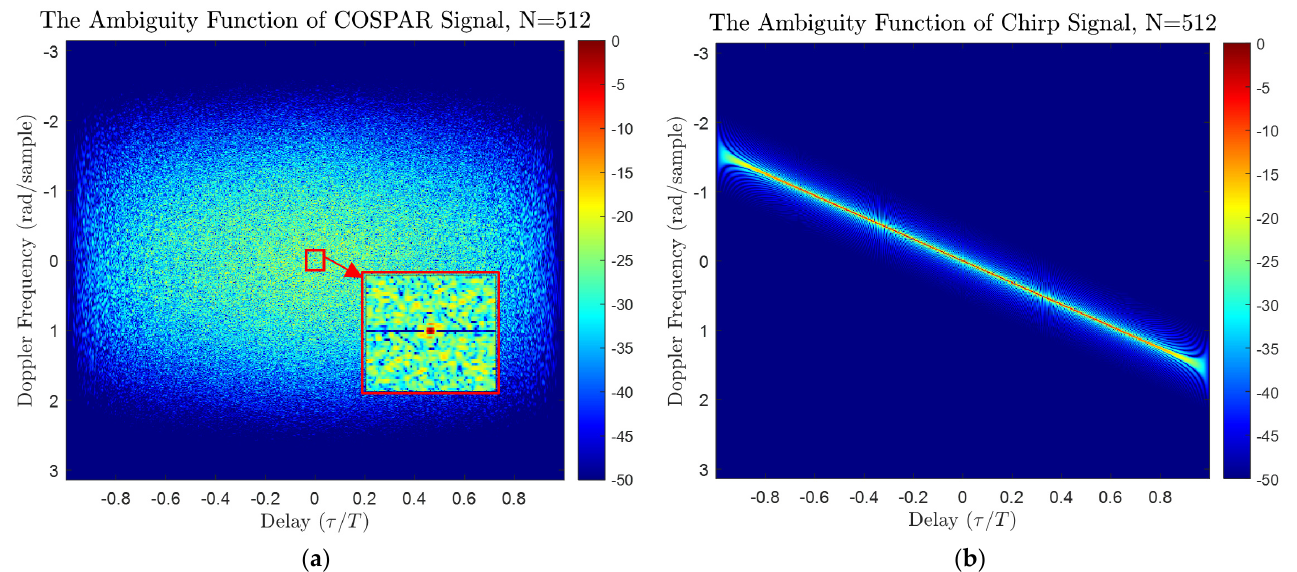
Figure 14. ( a ) Ambiguity Function of COSPAR signal. ( b ) Ambiguity Function of LFM signal.